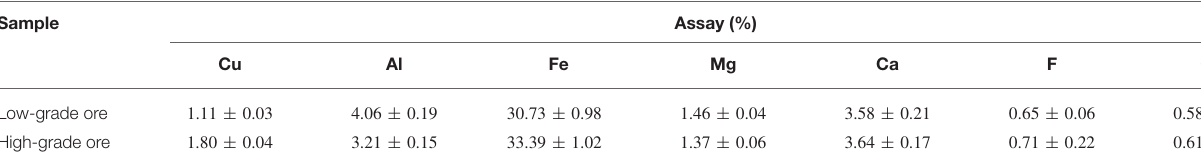
TABLE 1 | Main elements analyzed in the two ore samples. Sample